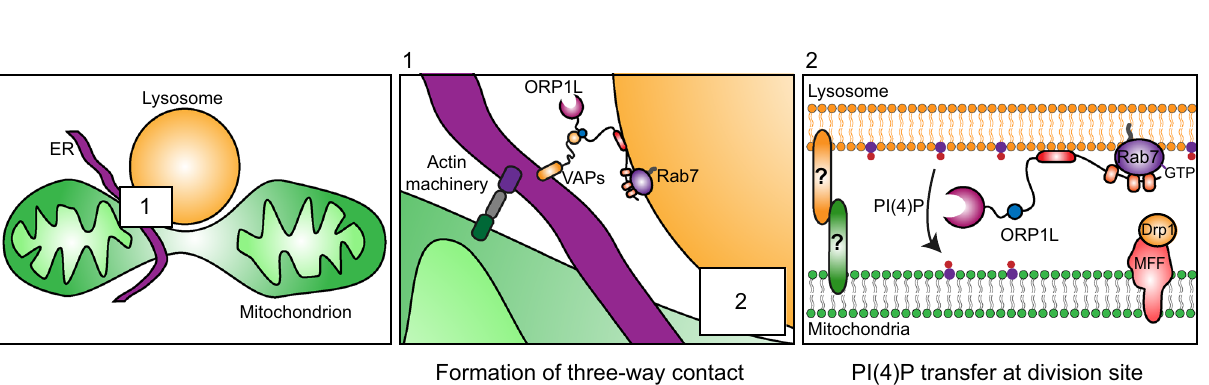
Fig. 8 Proposed model for ORP1L functions at the mitochondrial division site. Mitochondrial division initiates at contacts with the ER, where the ER drives the constriction of mitochondrial membranes. This implicates an actin machinery that involves the ER protein INF2 and the mitochondrial Spire1C. The constriction allows the recruitment of Drp1 by adapters such as MFF and its oligomerization that further constrict mitochondrial membranes (non- represented in the cartoon). Lysosomes are then recruited to the division site in a process mediated by the Rab7-ORP1L-VAPs interaction that establishs contact sites with the ER ( 1 ). This allows the formation of a three-way contact between the ER, the lysosome and mitochondria at the division site that brings the lysosome in contact with mitochondria. Lysosome-mitochondria tethers are still unknown. At the Lysosome-mitochondria contact ( 2 ), we propose that ORP1L mediates the transfer of PI(4)P from lysosome to the division site. This model is supported by the impaired mitochondrial division when this transfer is inhibited or when PI(4)P is depleted at the mitochondrial division